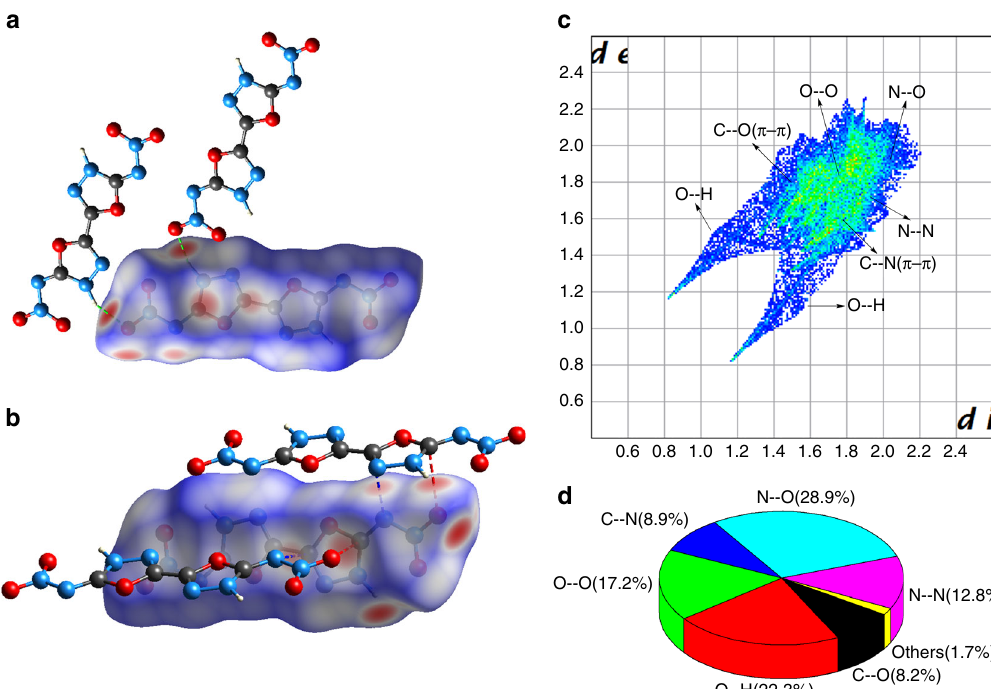
Fig. 4 Hirshfeld surfaces calculation of ICM-101. a Hydrogen bond interaction of Hirshfeld surfaces of ICM-101. b π -type interaction of Hirshfeld surfaces of ICM-101. c Two-dimensional fi ngerprint plots in the crystal stacking of ICM-101. d The individual atomic contact percentage contribution to the Hirshfeld surface Table 1 Physical properties of ICM-101 and comparison with HMX, RDX and ε -CL-20